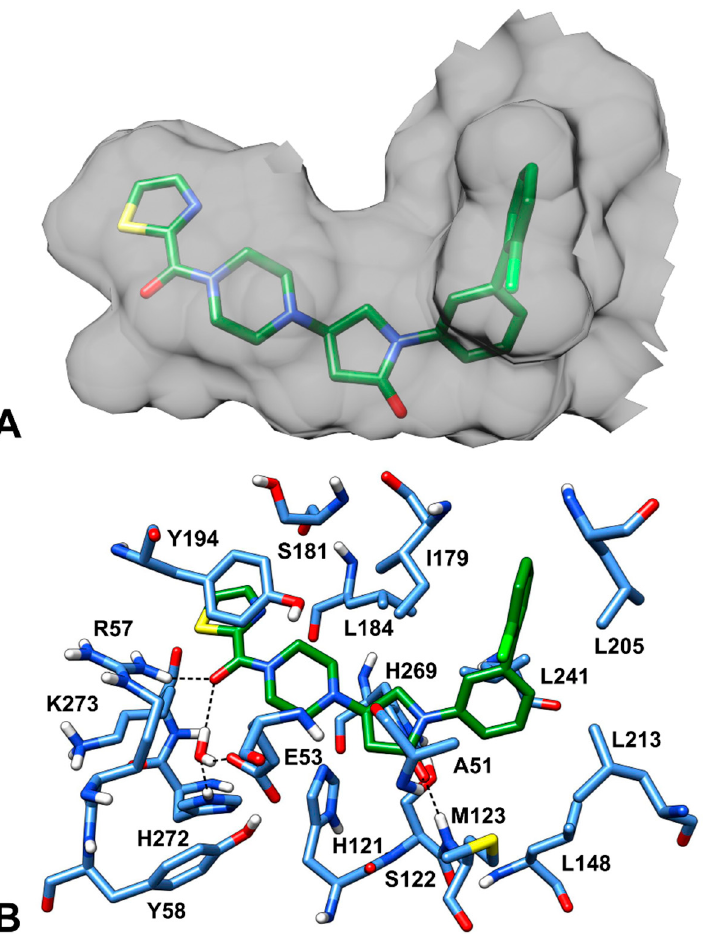
Figure 1. Piperazinyl-pyrrolidine inhibitor 3l in the MAGL binding site (PDB code: 5ZUN). ( A ) The inner surface of the protein surrounding the ligand (green sticks), displaying the shape of the ligand-binding cavity, is shown in gray. ( B ) The protein residues surrounding the ligand, constituting the binding site, are show in blue sticks, while hydrogen bonds are shown as black dashed lines.